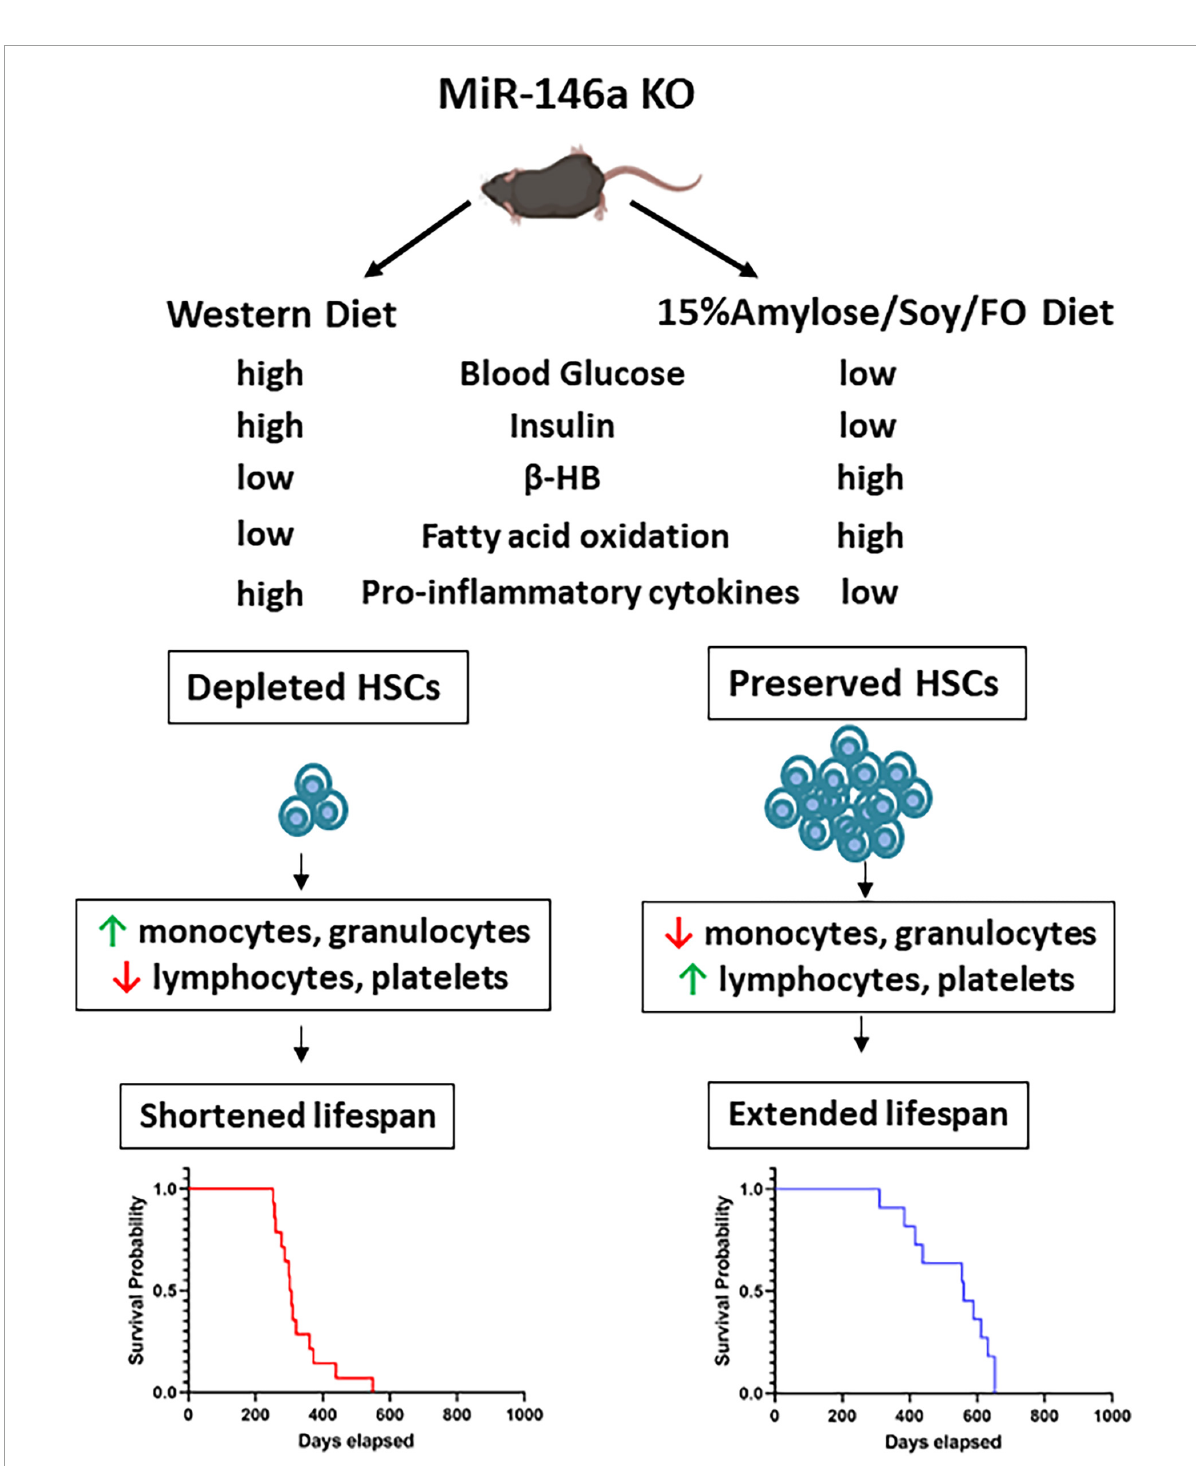
FIGURE7 Proposed mechanisms by which a 15%Amylose/Soy/FO diet extends the lifespan of miR146a KO mice. In the absence of the anti-inflammatory microRNA, miR146a, monocytes and other myeloid cells express higher levels of pro-inflammatory cytokines. These cytokines induce miR146a KO HSCs to proliferate and differentiate, especially down the myeloid lineage. Over time, the HSCs are depleted and the mice die due to myelo-malignancies. Consumption of a 15%Amylose/Soy/FO reduces the levels of pro-inflammatory cytokines as well as blood glucose, and insulin and promotes FAO. Together, this preserves the pool of HSCs and ameliorates the aberrant blood cell profile associated with miR146a KO. This delays meylo-malignancy-induced death in these